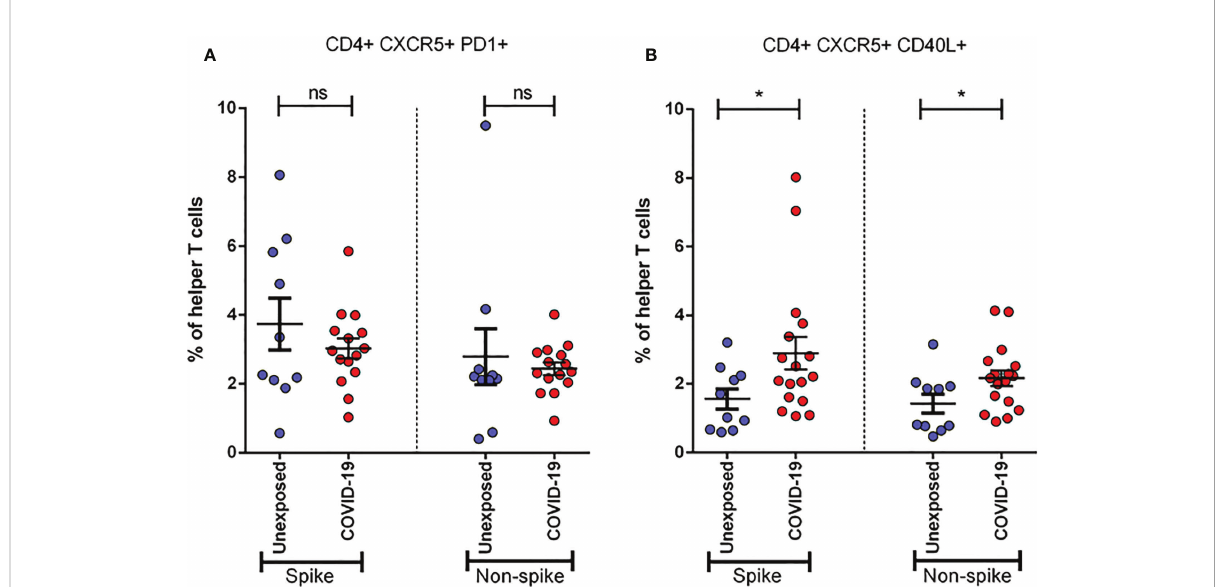
FIGURE 6 Activation of Follicular Helper T cells (Tfh) in unexposed controls (n= 10)& severe COVID-19 patients (n=15). Samples were collected after one month (Day 28) of infection and response was observed for stimulation by both Spike and Non-spike antigens. (A) Frequency of CXCR5+ PD1+ cells in helper T cells; (B) Frequency of CXCR5+ CD40L+ cells in helper T cells. Statistical comparisons were done using a two-tail Mann- Whitney test. *p<0.05; ns: non-signi fi